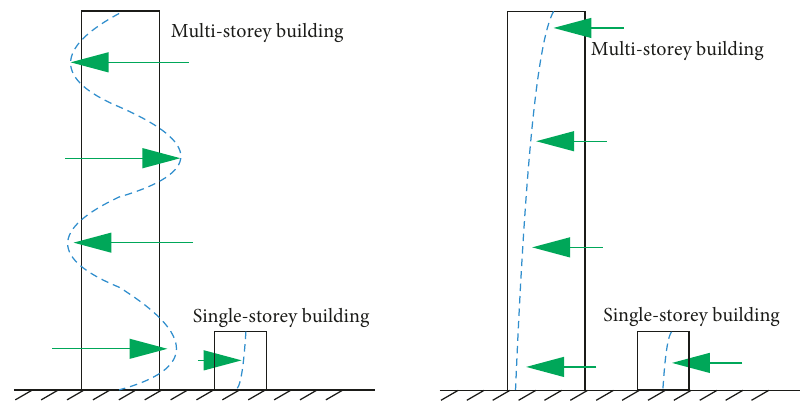
Figure 17: Effect of frequency of seismic wave on building.